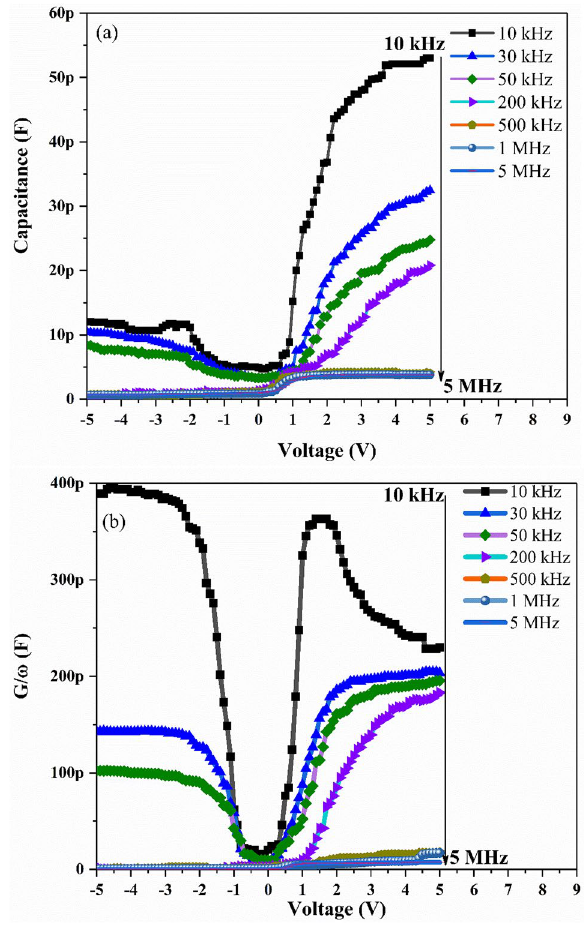
Figure 1. Plots of the ( a ) C–V and ( b ) G/ω–V for the Ag/TiO 2 -NW/Ge-NW/Si (MOS)